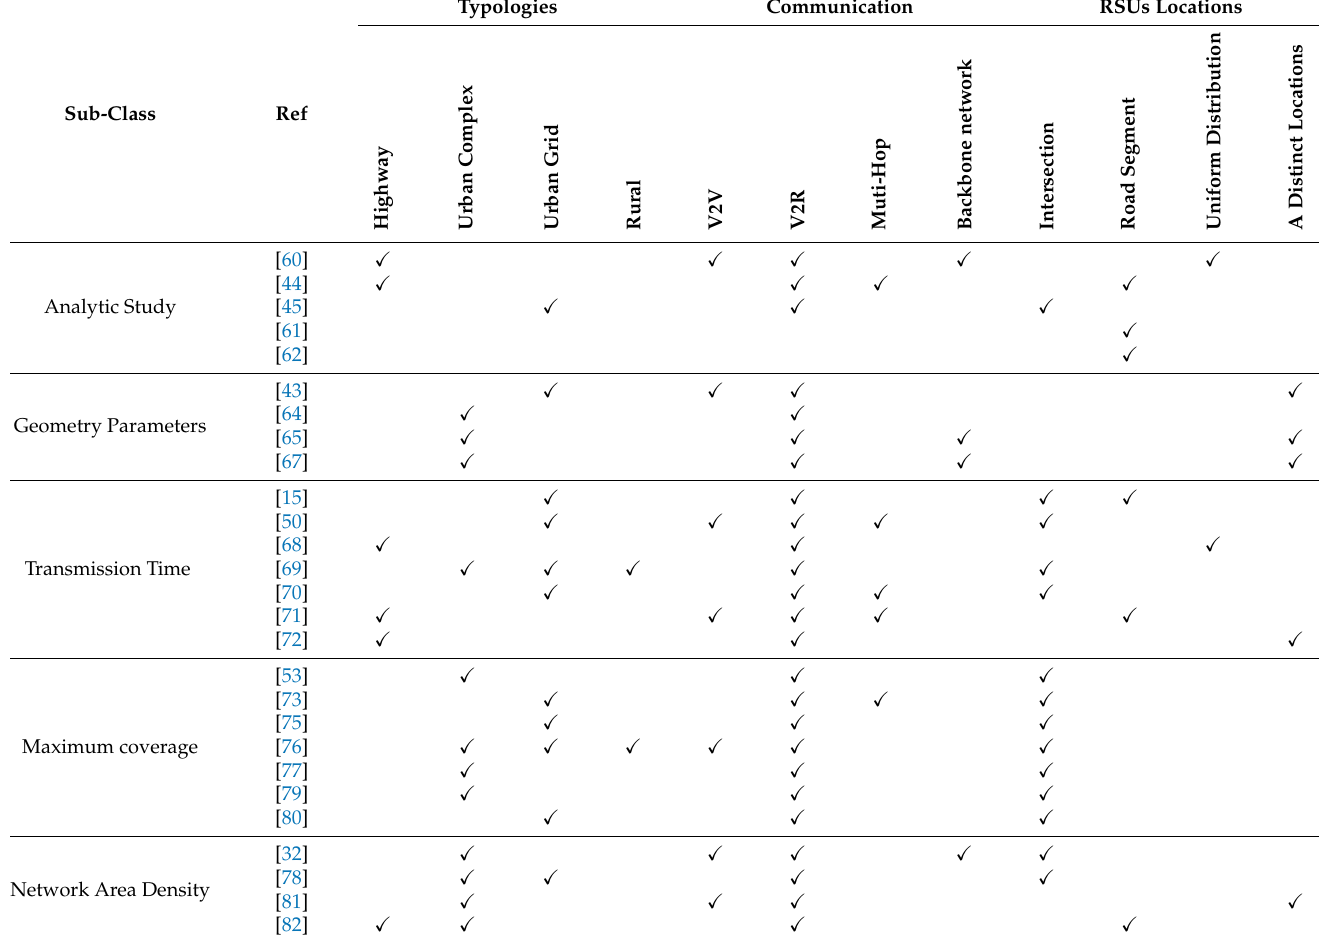
Table 1. A comparison between the various static deployment